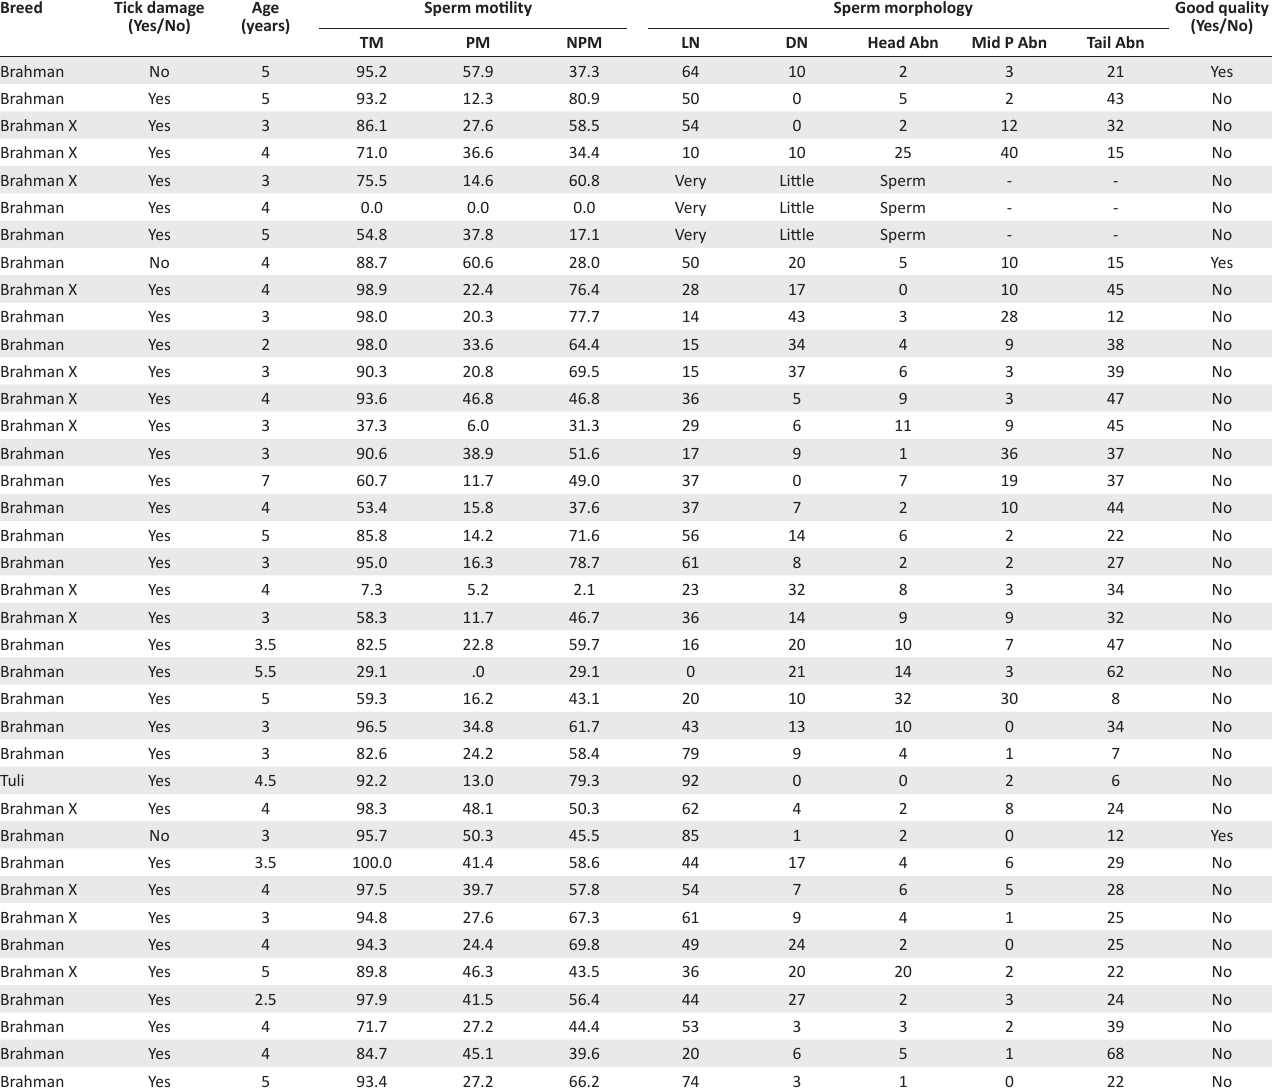
TABLE 2: Results of breeding soundness examinations and semen evaluation done on communal bulls. Breed Tick damage (Yes/No)